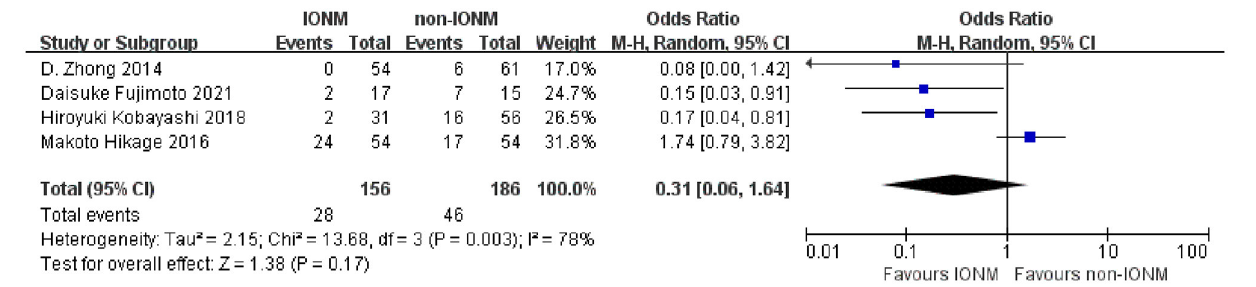
FIGURE 8 | Forest plot of aspiration in the IONM and non-IONM groups.